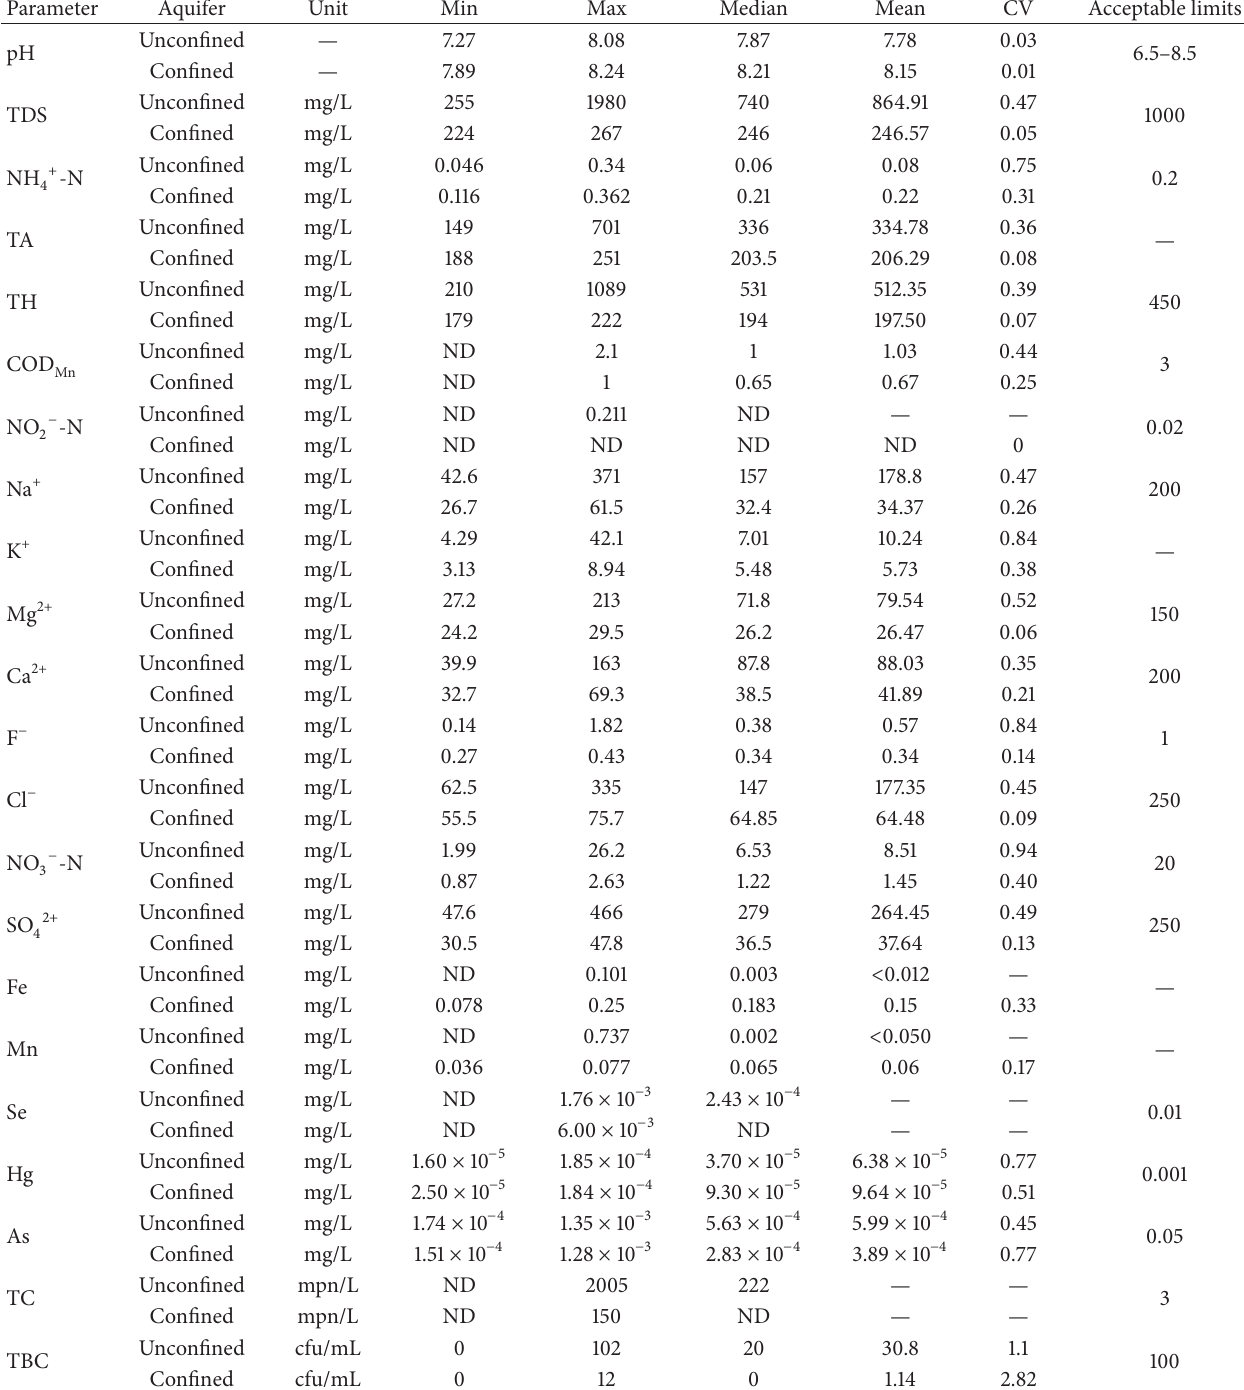
Table 1: Statistics of groundwater quality